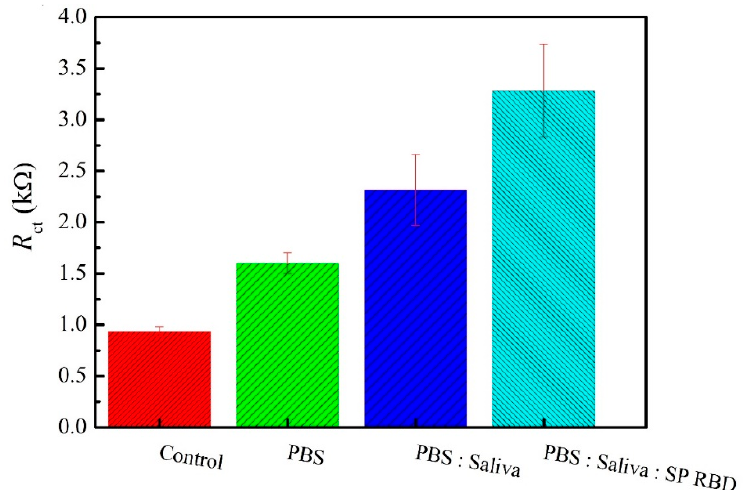
Figure 6. Response of the proposed immunosensor towards detecting SARS-CoV-2 spike protein RBD in real saliva sample.